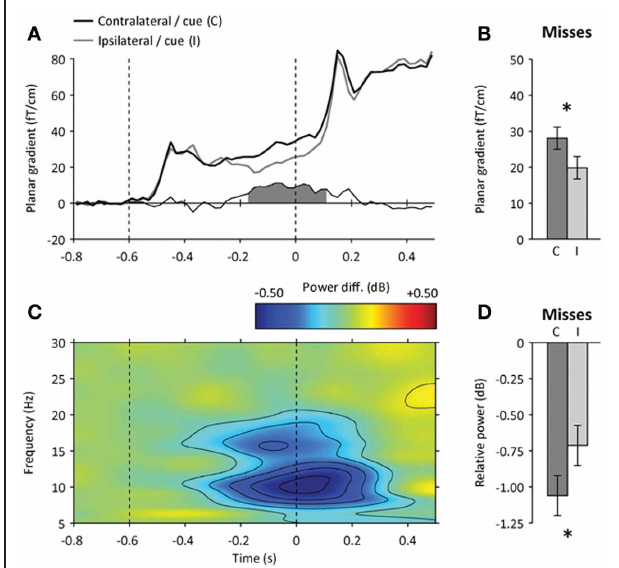
FIGURE 3 | Neural correlates of spatial attention before target onset. (A) Time course of event-related signals contralateral (black) and ipsilateral (gray) to the direction of the spatial cue at the parietal ROI. The amplitude difference between contralateral and ipsilateral signals is shown below. The shaded area indicates a significant amplitude difference from 200ms before target onset ( p < 0 . 05). (B) Amplitude difference between contralateral (C) and ipsilateral (I) signals for missed targets presented at the cued location (200–0ms before target onset). Error bars indicate within-subject s.e.m. The star indicates a significant hemispheric difference ( p < 0 . 05). (C) Time-frequency map of the difference in spectral power between parietal signals contralateral and ipsilateral to the direction of the spatial cue. The amplitude difference was accompanied by a focal suppression of ongoing alpha-band oscillations before target onset (in blue). (D) Contralateral attentional suppression of ongoing alpha-band oscillations for missed targets presented at the cued